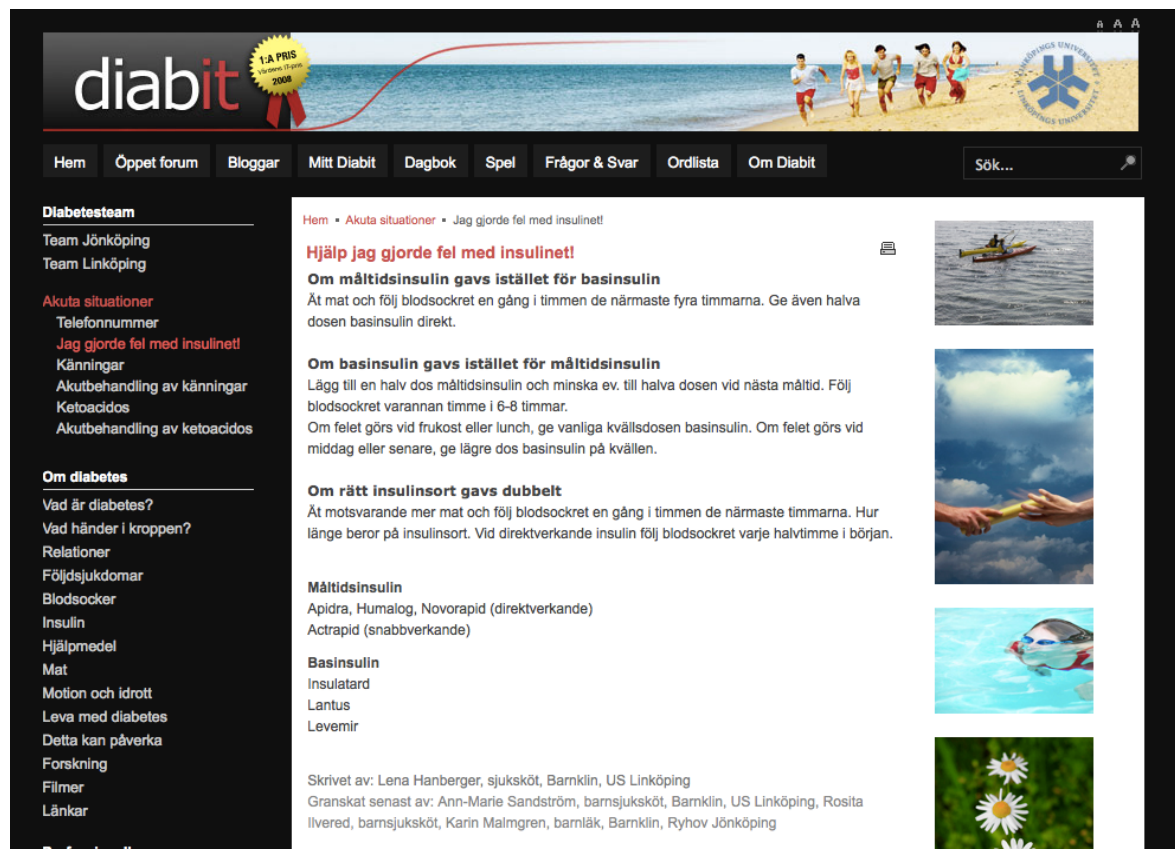
Figure 1. A sample of practitioner information entitled “I made a mistake with the insulin!” with advice for specific emergencies. The text at the bottom of the screen includes “Written by…”, “Revised by…” (names,